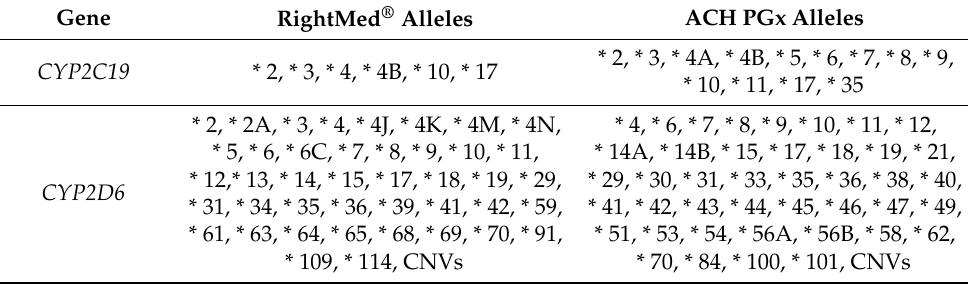
Table 1. CYP2C19 and CYP2D6 star alleles (*) on the RightMed ® Test and the ACH PGx panel. Gene RightMed ® Alleles ACH PGx Alleles